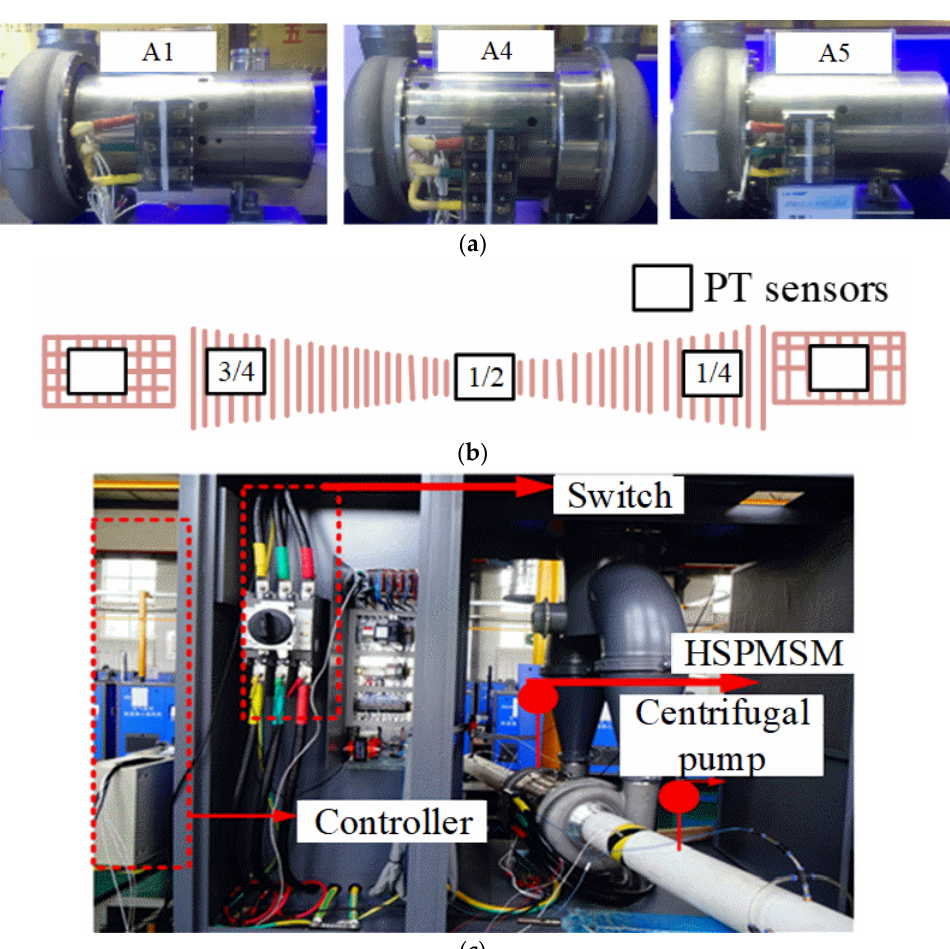
Figure 14. Experimental test; ( a ) HSPMSM prototypes; ( b ) setup for PT sensor to monitor temperature rise in a phase winding; ( c ) prototype setup for centrifugal blower application.